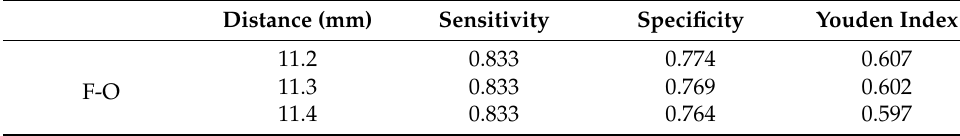
Figure 4. The receiver operating characteristic (ROC) curve showed that frontal sinus roof ‒ supraorbital margin (F-O) and frontal sinus roof ‒ nasion (F-N) distances had greater areas under the receiver operating characteristic curve (AUC). Table 5. The sensitivity, specificity, and Youden index in F-O and F-N.